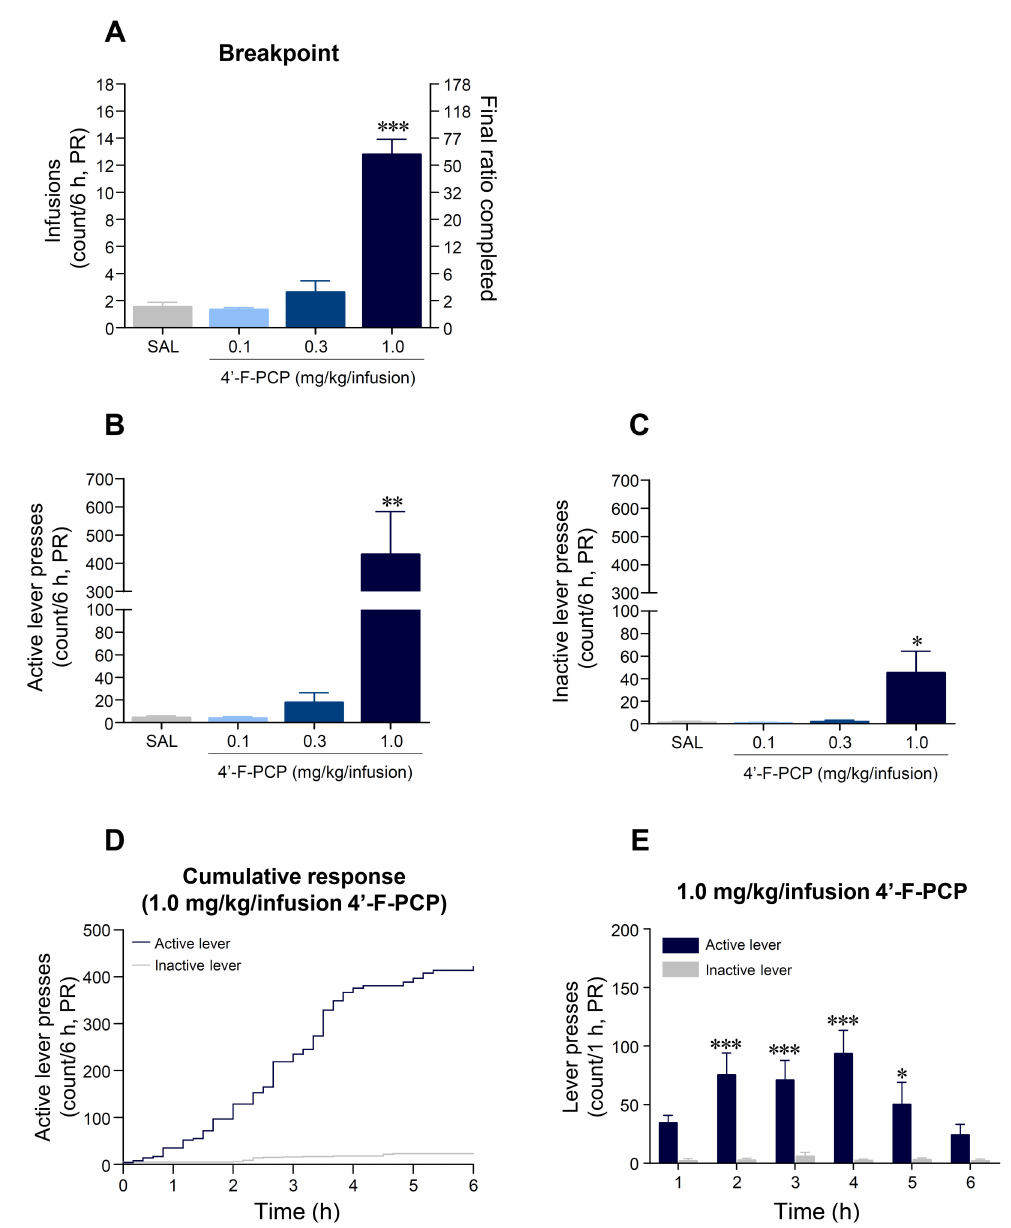
Figure 4. The reinforcing strength of 4 (cid:48) -F-PCP self-administration under the progressive ratio (PR) schedules in rats. ( A ) Breakpoint of saline and 4 (cid:48) -F-PCP (0.1, 0.3, or 1.0 mg / kg / infusion) during 6 h under the PR sessions (Day 11–14). Left y-axis and right y-axis indicate the mean of drug infusions and final ratio completed to access saline or 4 (cid:48) -F-PCP for 4 days of PR schedule, respectively. ( B , C ) Mean number of active and inactive lever-pressing responses of saline or 4 (cid:48) -F-PCP-self-administration under the PR schedules. ( D ) Representative plots for cumulative active and inactive lever responses at 1.0 mg / kg / infusion 4 (cid:48) -F-PCP-self-administering rats during the final session of PR schedule. ( E ) Temporal analysis of active and inactive lever responses at the final session of PR schedule of 1.0 mg / kg / infusion 4 (cid:48) -F-PCP-self-administered rats. Asterisk *, **, and *** indicate p < 0.05, p < 0.01, and p < 0.001, respectively, vs. inactive lever. SAL: saline. n = 6 per